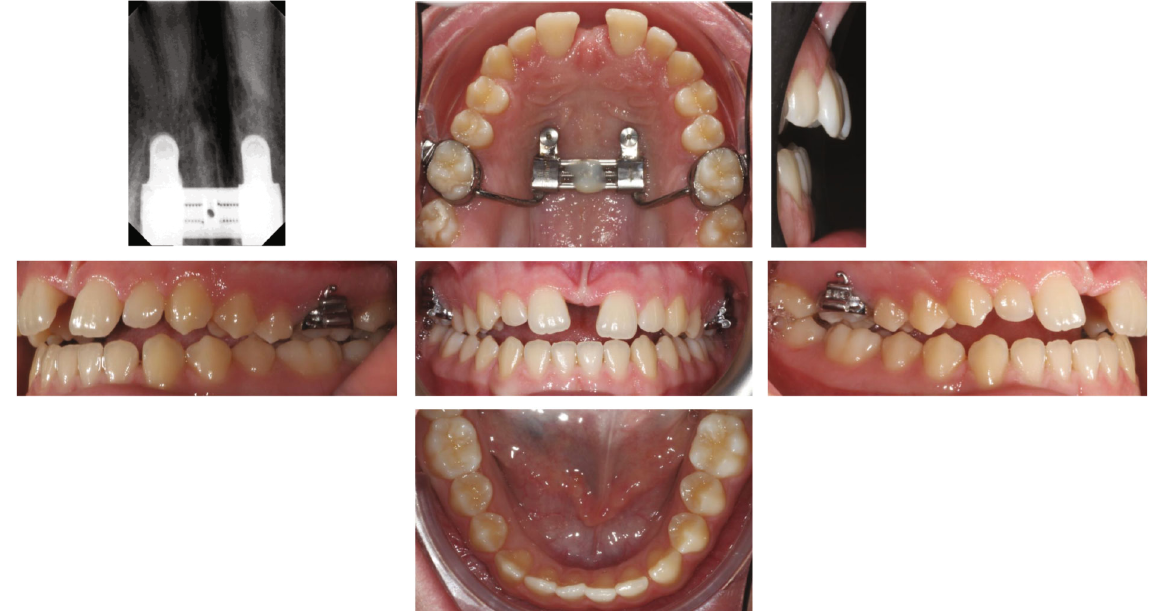
Figure 9: Before expansion treatment.